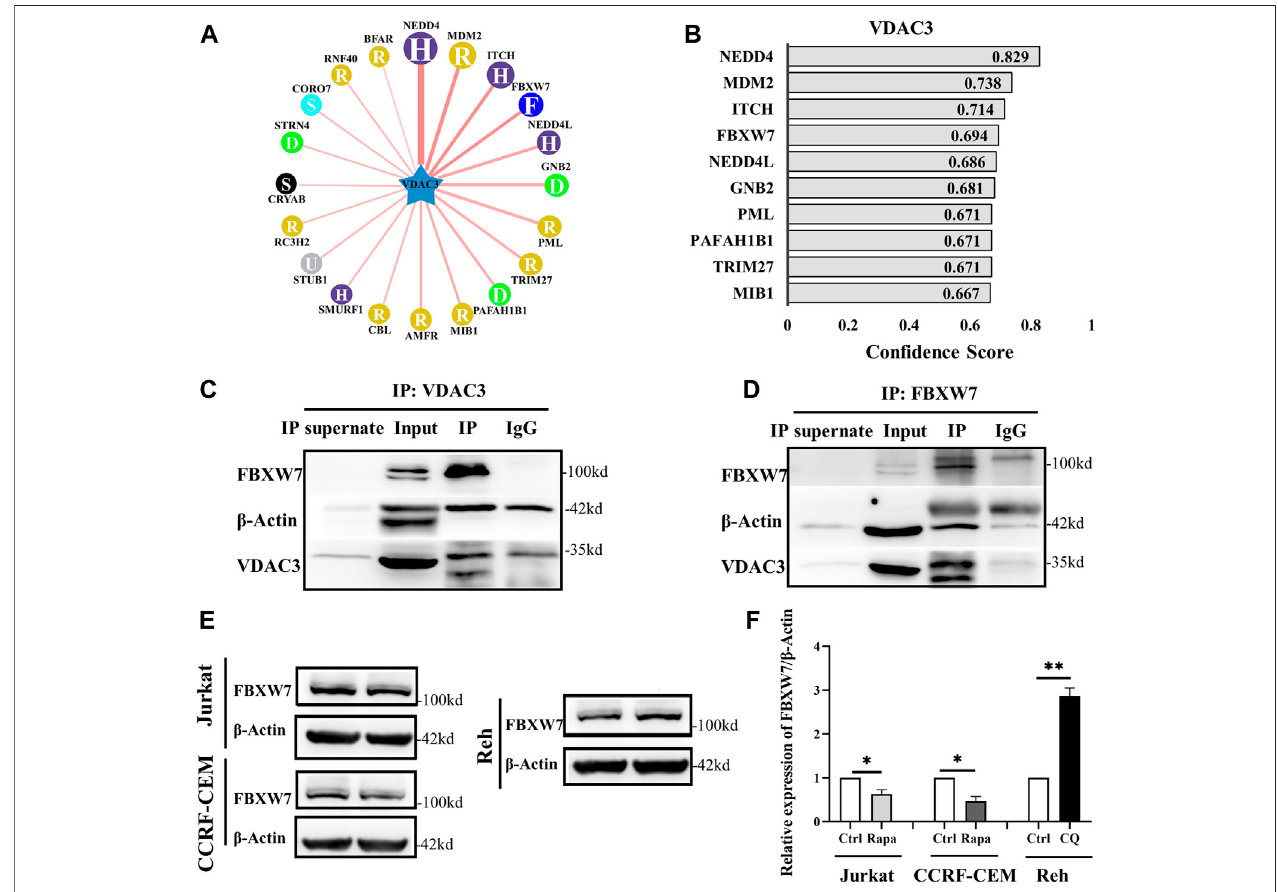
FIGURE 3 | FBXW7 participated in the ubiquitination and degradation of VDAC3. (A,B) Top 10 E3 ligases of VDAC3. (C) Whole cell lysates were prepared and subjected to immunoprecipitation with either VDAC3 antibody or normal IgG antibody. A FBXW7 antibody was used for IB. (D) Whole cell lysates were prepared and subjected to immunoprecipitation with either the FBXW7 antibody or normal IgG antibody. A VDAC3 antibody was used for IB. (E) Comparison of expression levels of FBXW7 in Jurkat, CCRF-CEM, and Reh cells by IB. The expression of β -actin was examined as a control. (F) Histogram of the relative expression levels of FBXW7 under different treatments. Results are presented as means ± SD of three independent experiments. * p < 0.05, ** p < 0.01.